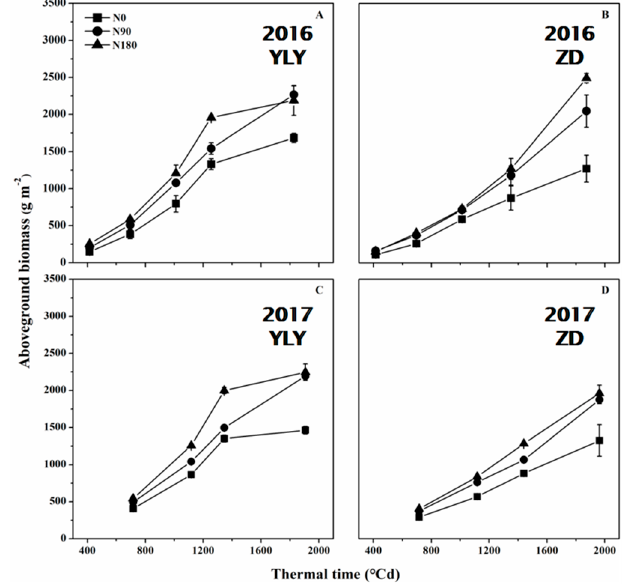
Figure 2. Above-ground biomass (AM) of YLY ( A,C ) and ZD ( B,D ) as a function of thermal time under different N treatments in 2016 ( A,B ) and 2017 ( C,D ). Vertical bars represent standard derivation (S.D.) of the mean ( n = 3) where these exceed the size of the